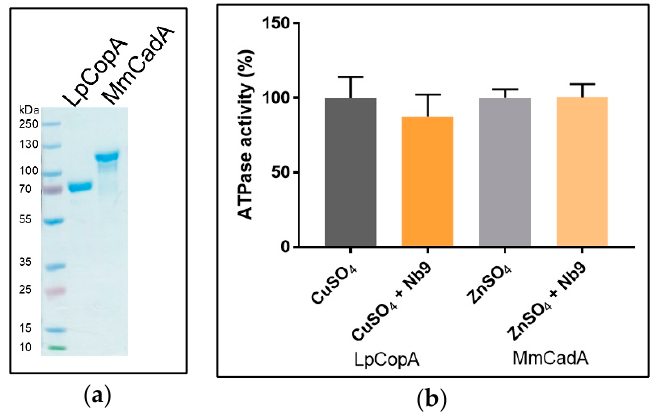
Figure 11. Nb9 specificity. ( a ) SDS-PAGE of purified Cu + -transporting P IB-1 -ATPase from Legionella pneumophila (LpCopA) and Cd 2+ and Zn 2+ -transporting P IB-2 -ATPase from Mesorhizobium metallidurans (MmCadA) ( b ) Nb9 was tested for specificity against LpCopA and against MmCadA, in the presence of Cu + or Zn 2+ , respectively. The results are normalized for the background in presence of the metal ion chelator EDTA.